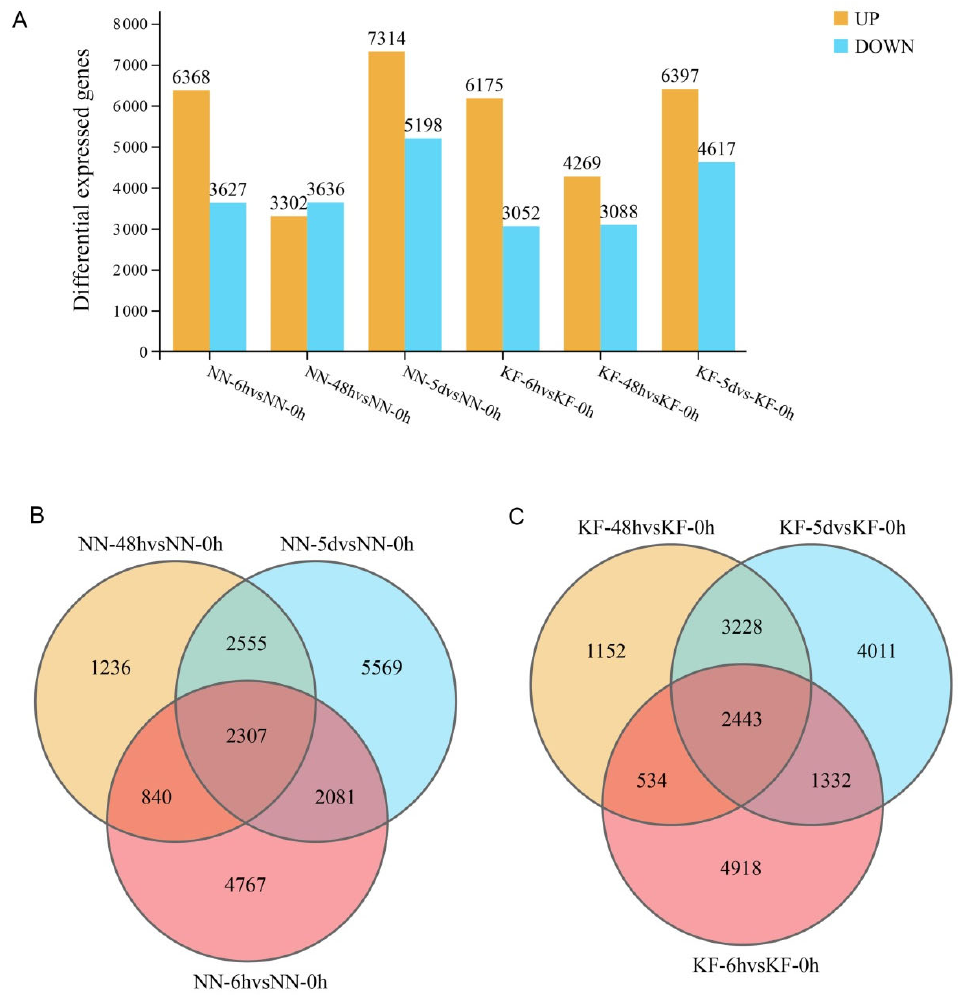
Figure 2. Differentially expressed genes (DEGs). ( A ): analysis of differential gene expression in NN 1138-2 and Kefeng-1. ( B ): analysis of common differential gene expression at different treatment times in NN 1138-2. ( C ): analysis of common differential gene expression at different treatment times in Kefeng ‐ 1.